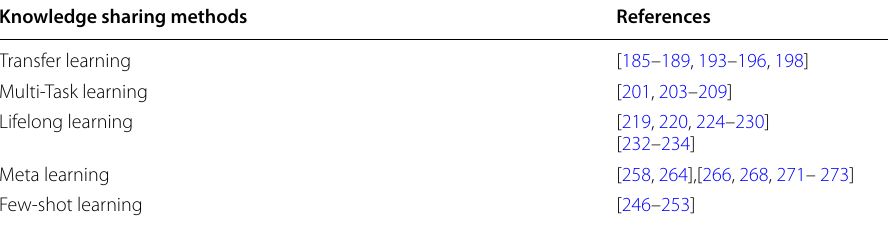
Table 3 Summary of knowledge sharing methods Knowledge sharing